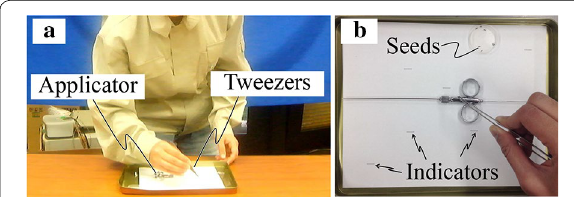
Fig. 22 a Scene in motion simulation of the traditional seed-loading process. b Top view of the